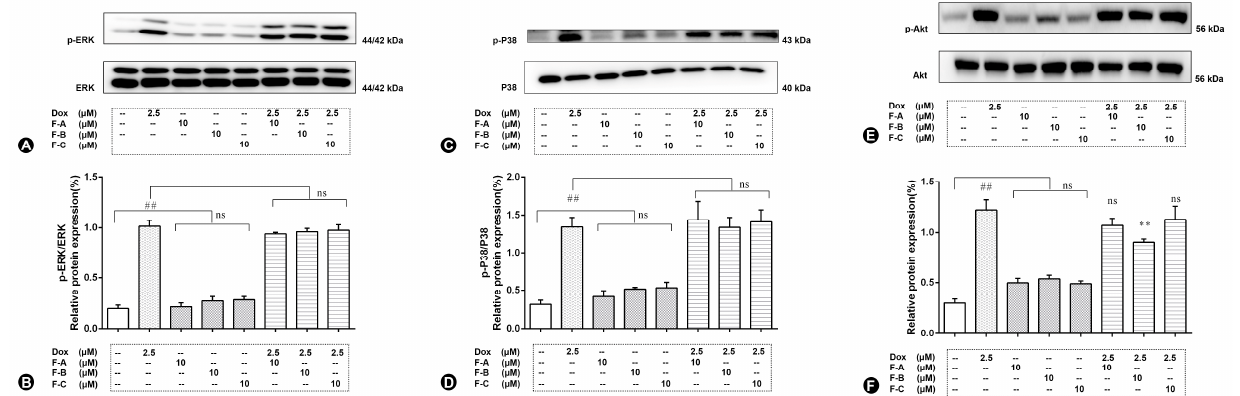
Figure 4. The effects of three flavonoids on p-ERK1/2 ( A , B ), p-P38 ( C , D ), and p-Akt ( E , F ) protein expression level of Dox-treated H9c2 cells. Cells were pretreated with same concentrations of F-A, F-B, and F-C (10 μ M) for 1 h, then exposed to Dox for 24 h. Relative folds of p-Akt, p-ERK1/2, and p-P38. ( B,D,F ) The relative expression level of p-P38, p-ERK, and p-Akt in Dox group significantly increased compared to the NC group ( p < 0.01). There was no significant activation of p-P38, p-ERK, and p-Akt in the F-A, F-B, and F-C group without Dox. However, F-A, F-B, and F-C had no significantly protective effect to reduce protein phosphorylation. Results are mean ± SEM from three independent experiments. ## p < 0.01 vs. control, ** p < 0.01 vs. Dox group. ns, not significant.